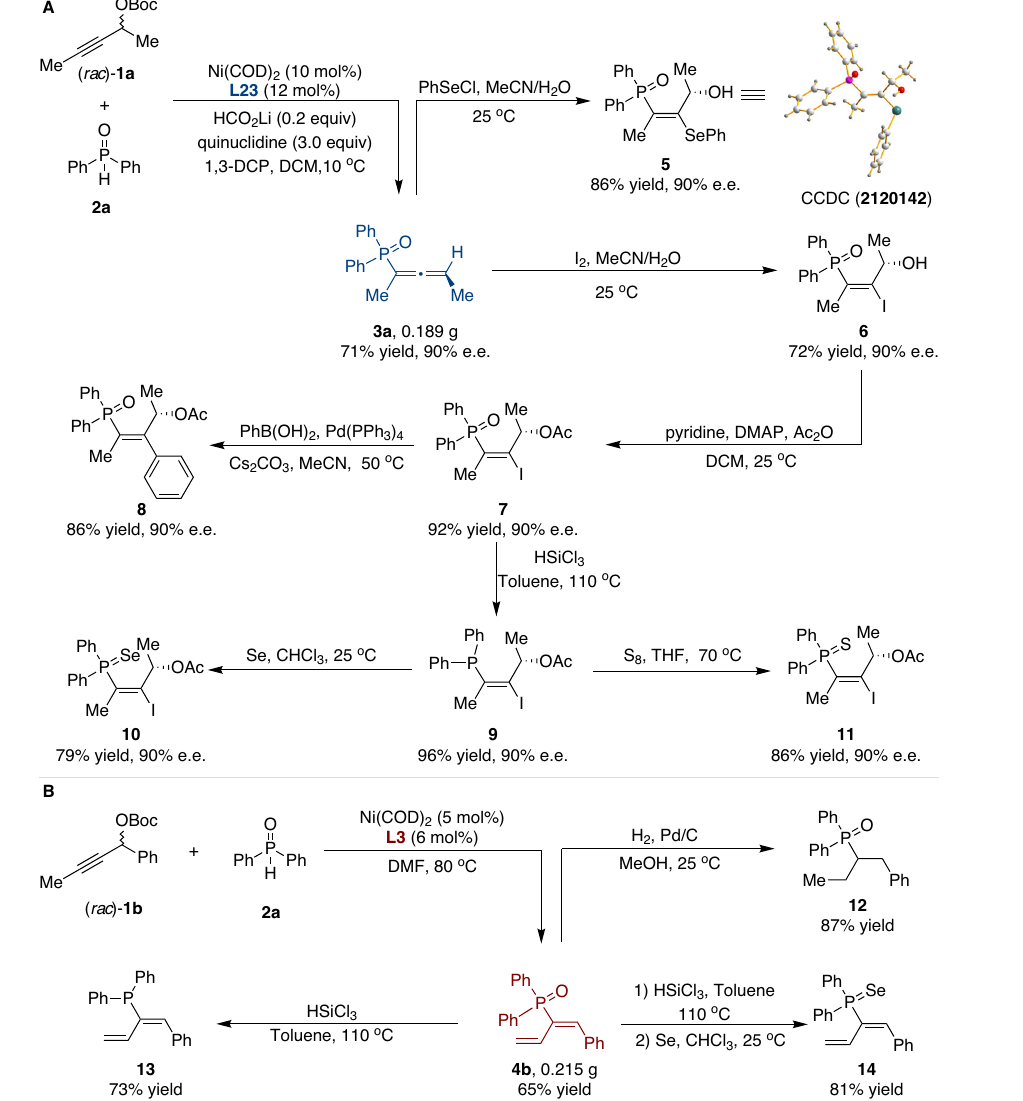
Fig. 5 | Synthetic versatility of the catalytic system. A Derivatization of product 3a . B Derivatization of product 4b